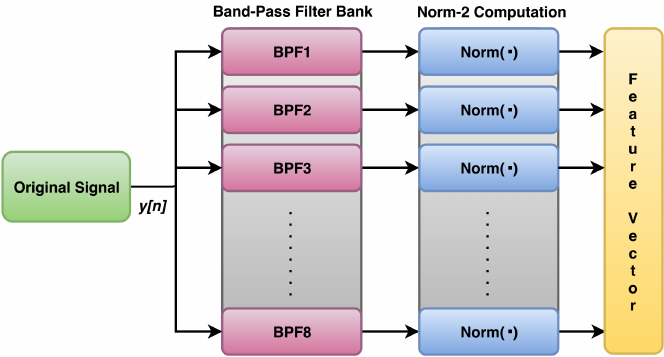
Figure 6. Process of feature extraction from Nyquist